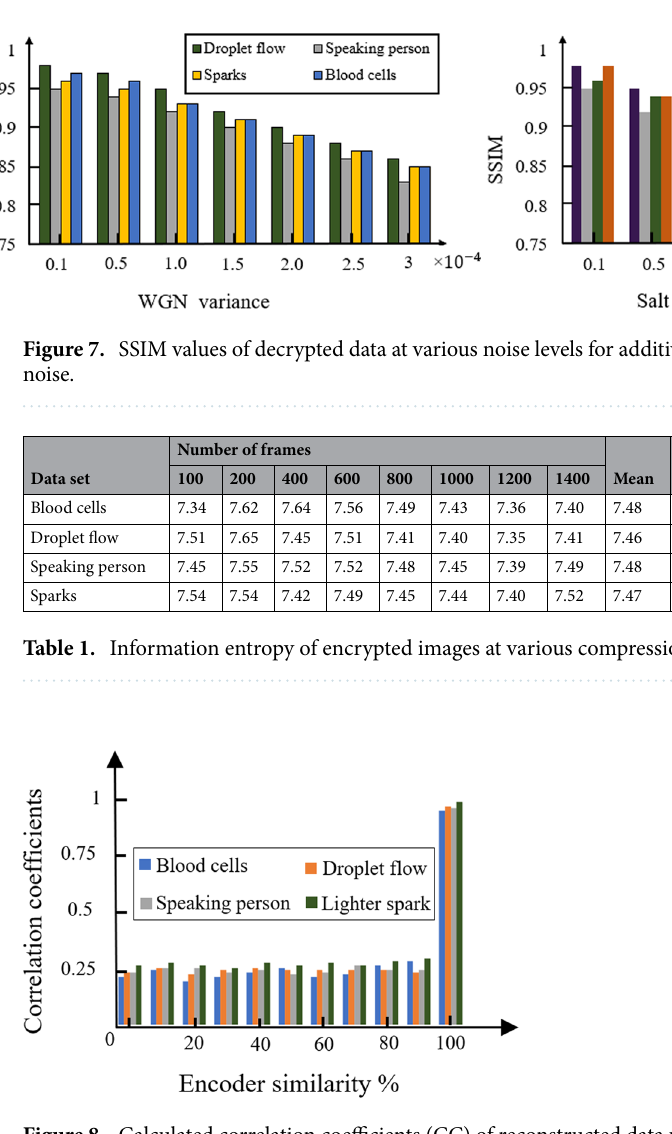
Figure 8. Calculated correlation coefficients (CC) of reconstructed data using encoder patters with various similarity percentages to the original encoder